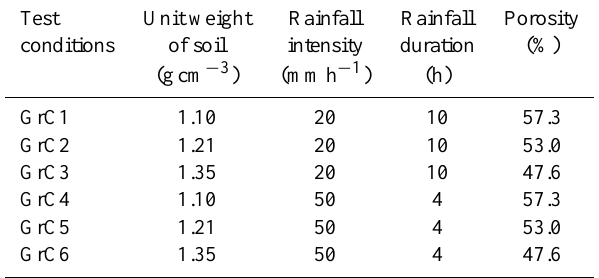
Table 2. Test conditions of the weathered soil. Test Unit weight